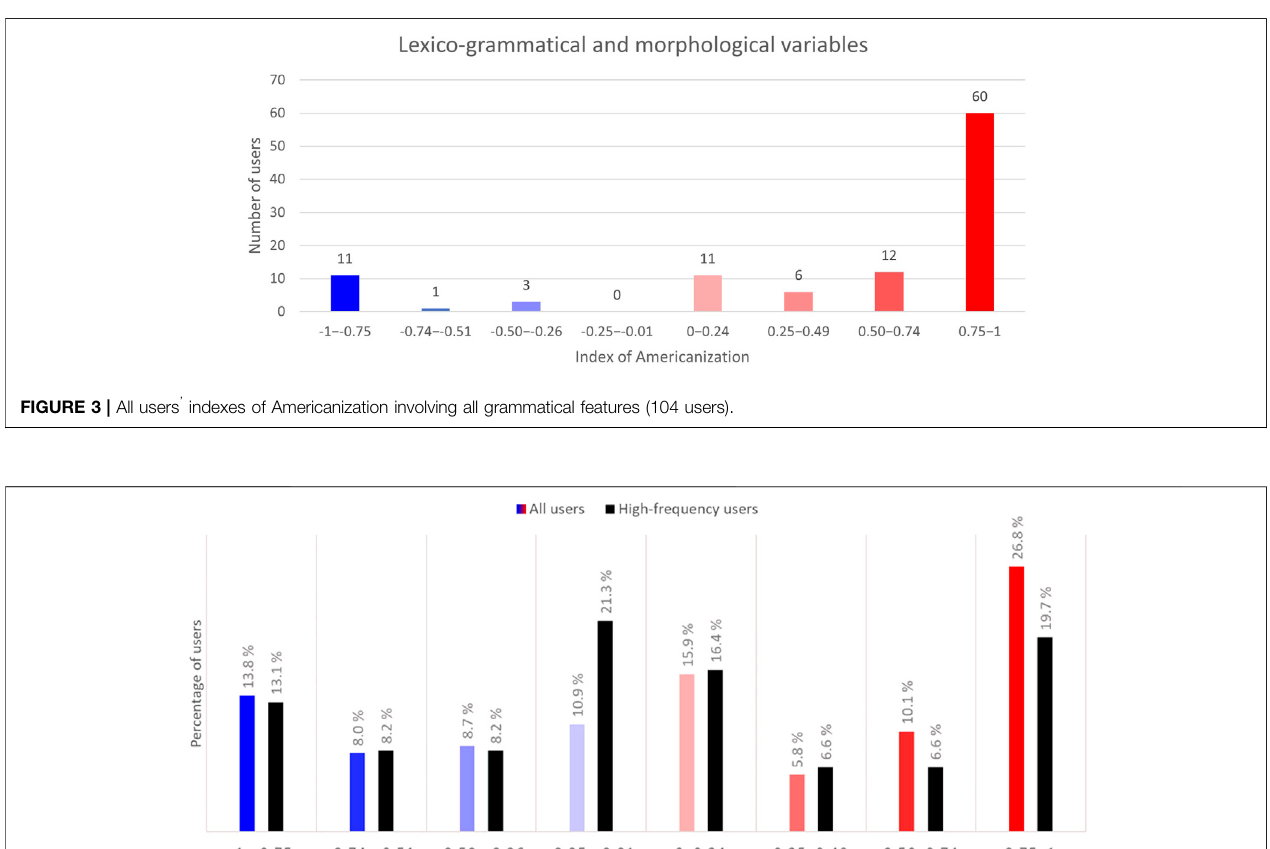
Frontiers in Communication |